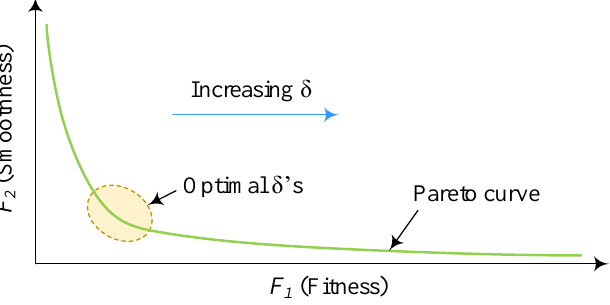
Figure 6. Typical Pareto curve for a bi-criterion vector optimization